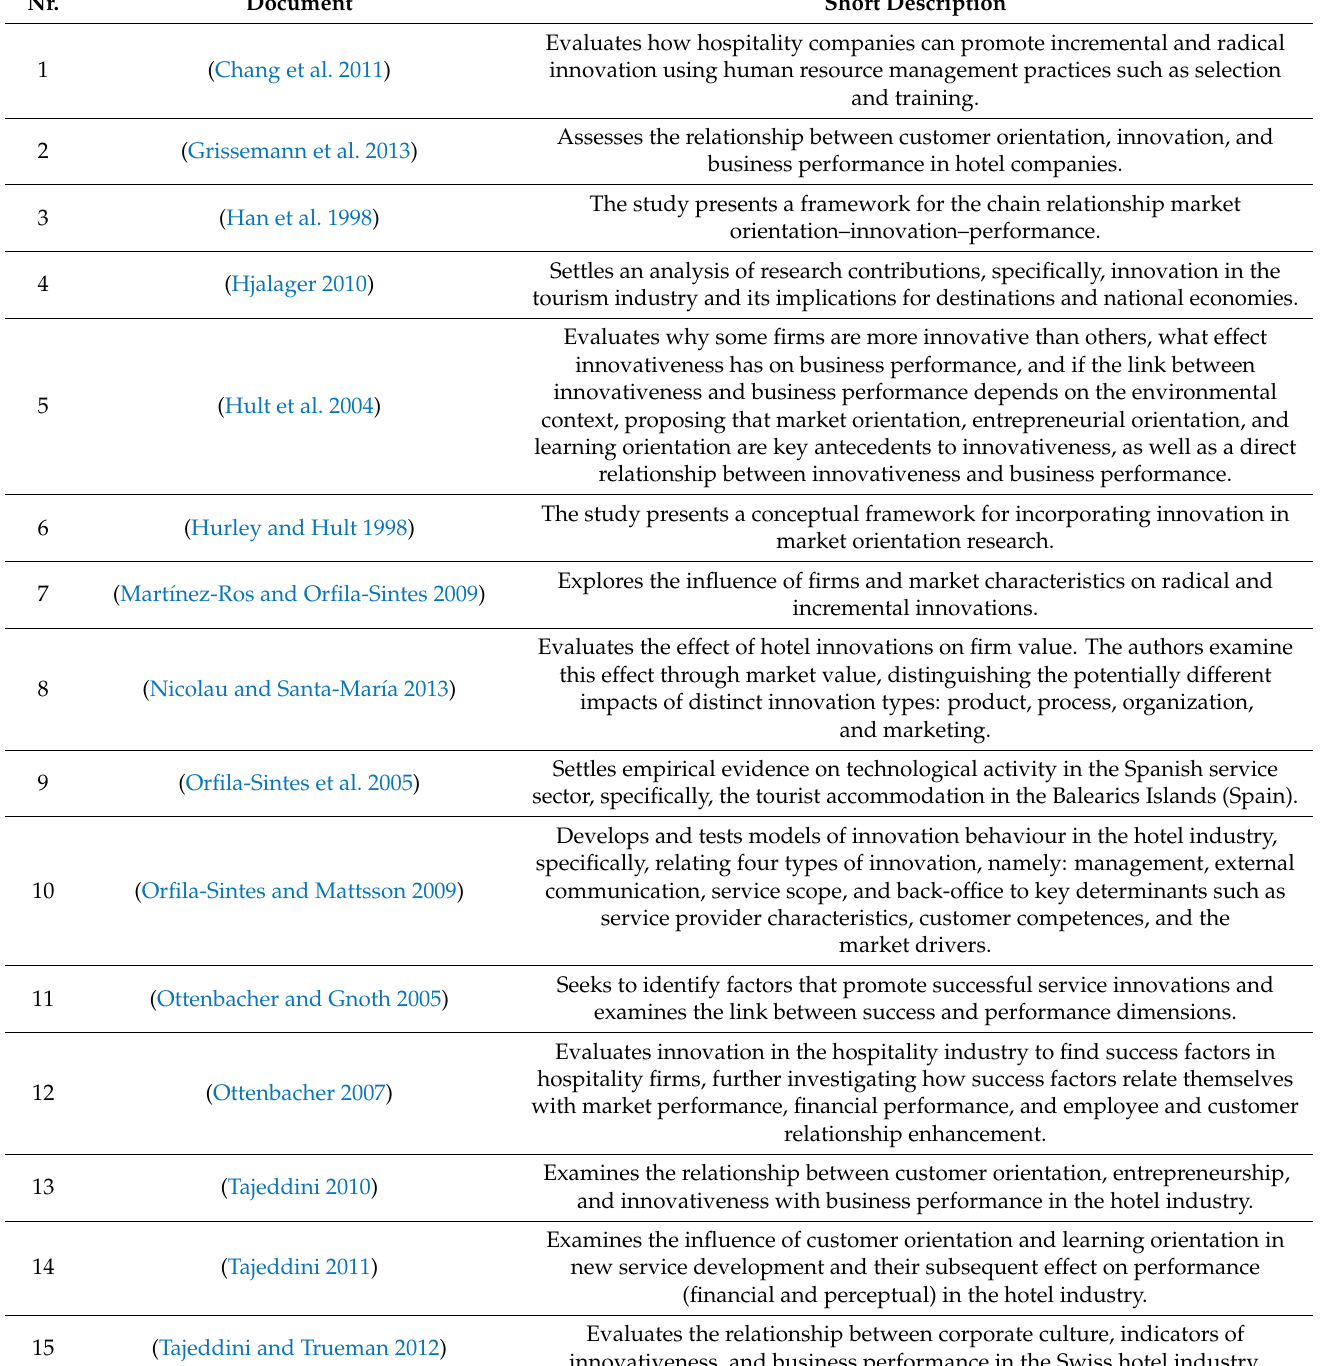
Table 4. Short descriptions of the cluster 3